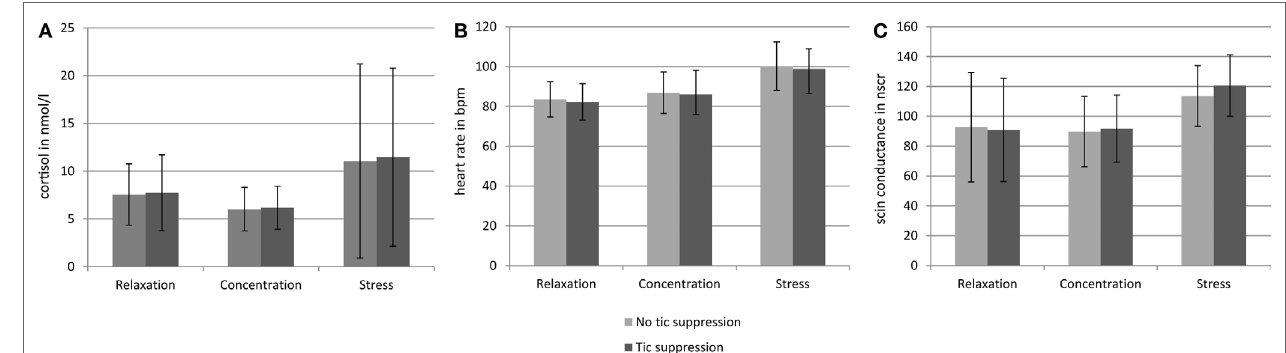
FigUre 3 | salivary cortisol level, heart rate, and skin conductance in the six different conditions . Error bars indicate the SDs. (a) Indicates the cortisol concentration in the saliva in nanomoles per liter obtained from the samples taken at the end of each of the six conditions. (B) Indicates the heart rate in beats per minute (bpm) during each of the six conditions. (c) Indicates the number of skin conductance responses (NSCR) during each of the six conditions. For the number of tics, see Figure 2 and Table 1